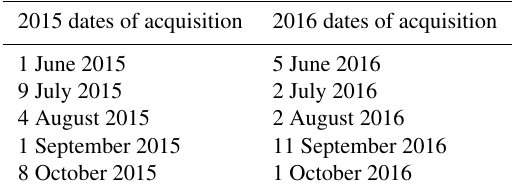
Table 1. Acquisition dates of Pleiades satellite imagery tasked for each month (June–October) in 2015 and